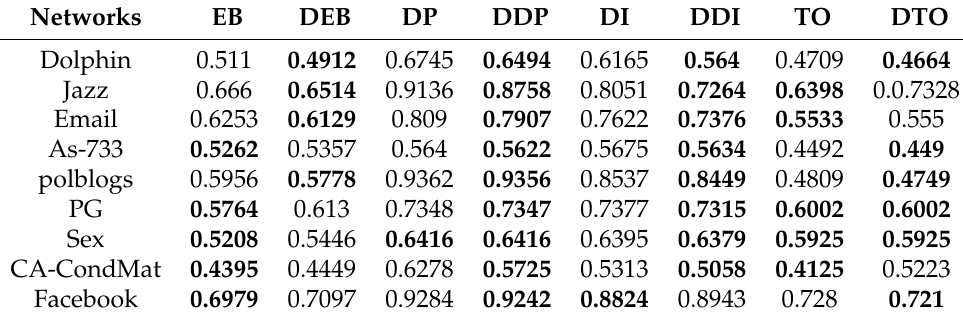
Table 7. The R of original methods and combination